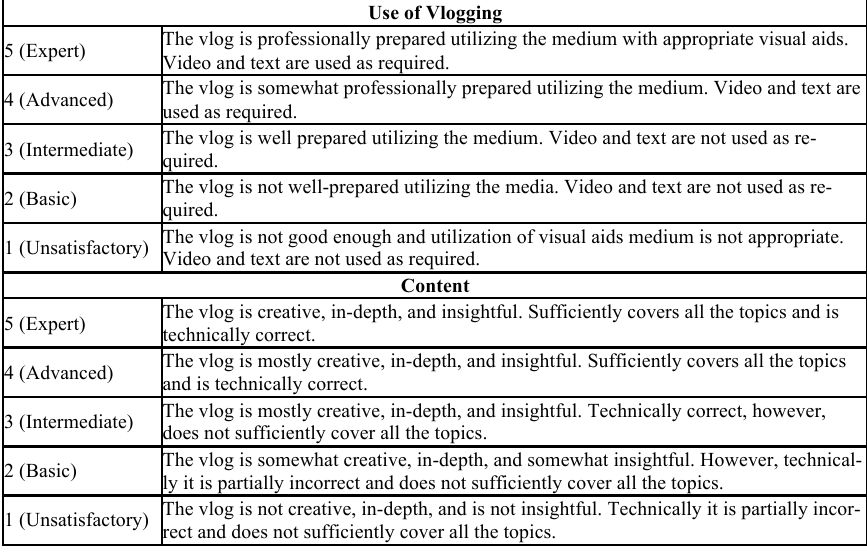
Table 2. Panel’s Perception Rubric for Evaluating